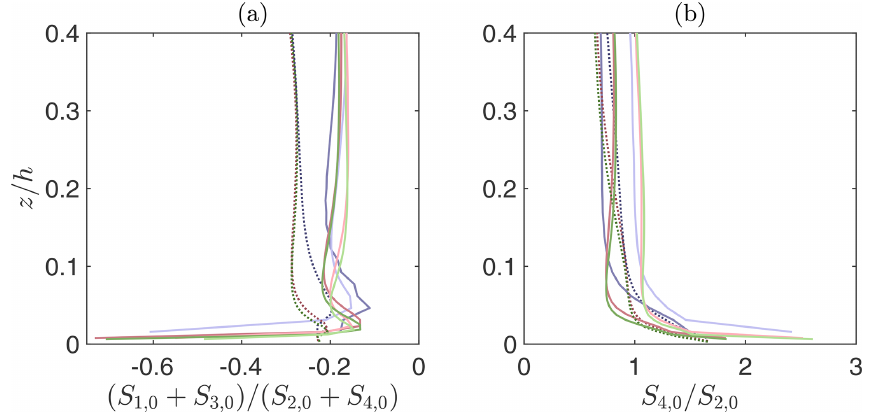
Figure 8. Vertical structure of event ratios: (a) ratio of negative to positive contributions to the momentum flux; (b) ratio of sweeps to ejections. Lines as in Fig.